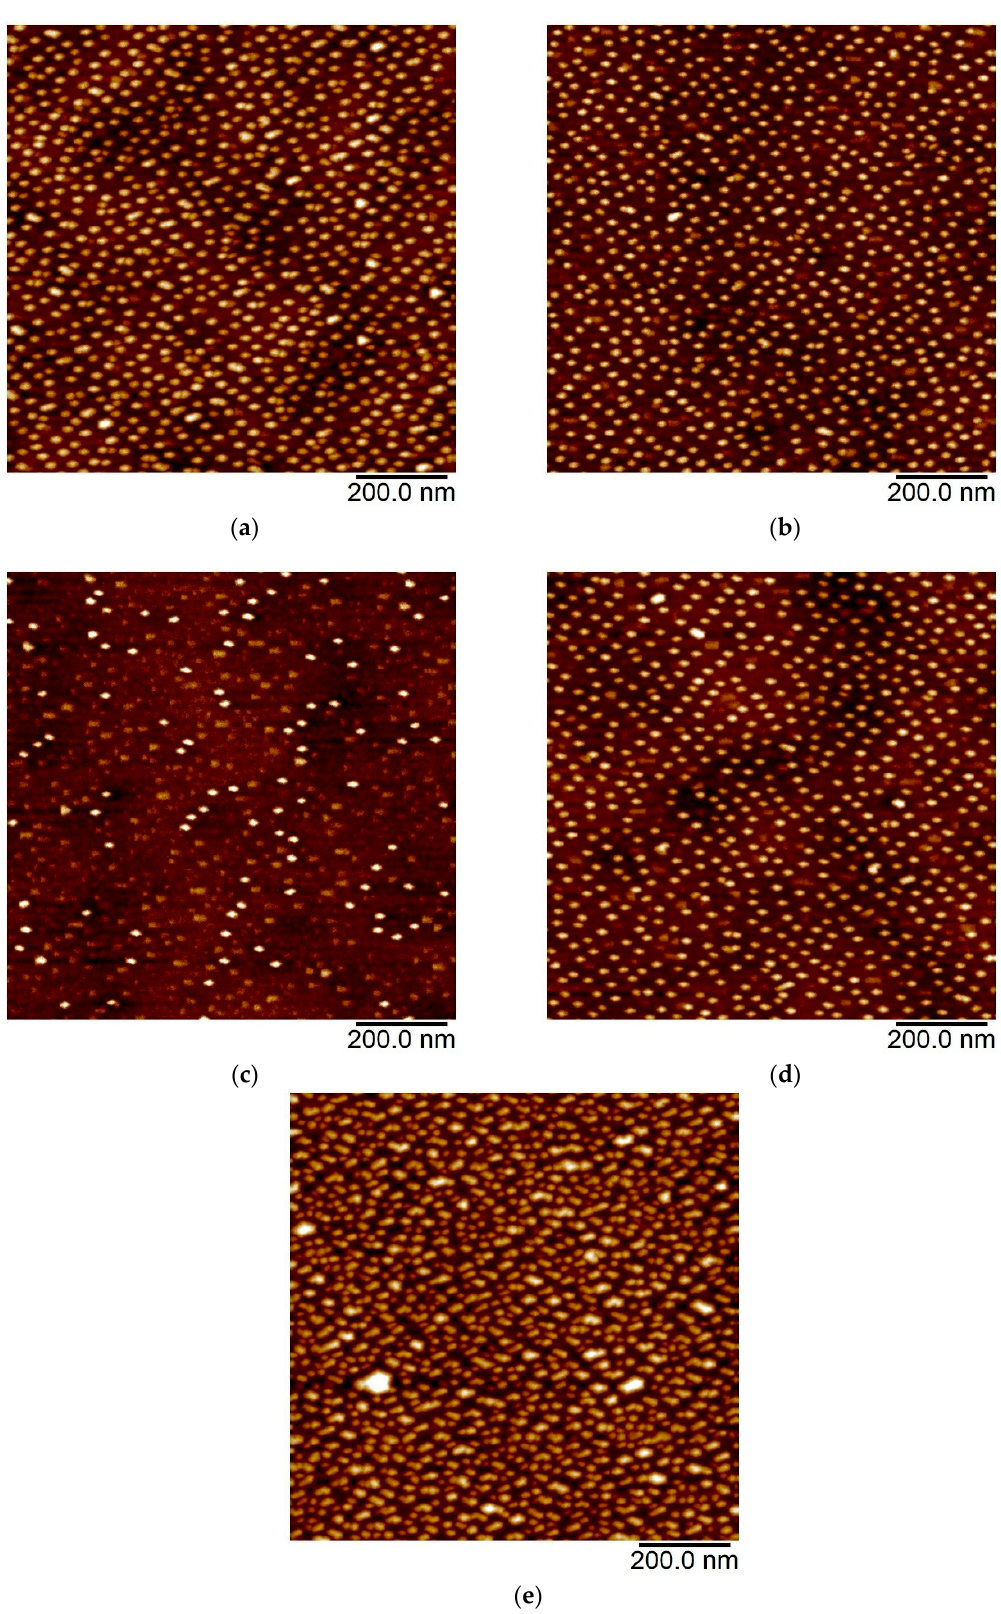
Figure 1. Reflection of high-energy electron diffraction (RHEED) pattern for InP(311)B substrate ( a ) after growth of the InP buffer layer, ( b ) after irradiation of As for 180 s at 470 °C, ( c ) for 240 s at 470 °C, ( d ) for 240 s at 450 °C, and ( e ) for 240 s at 430 °C.